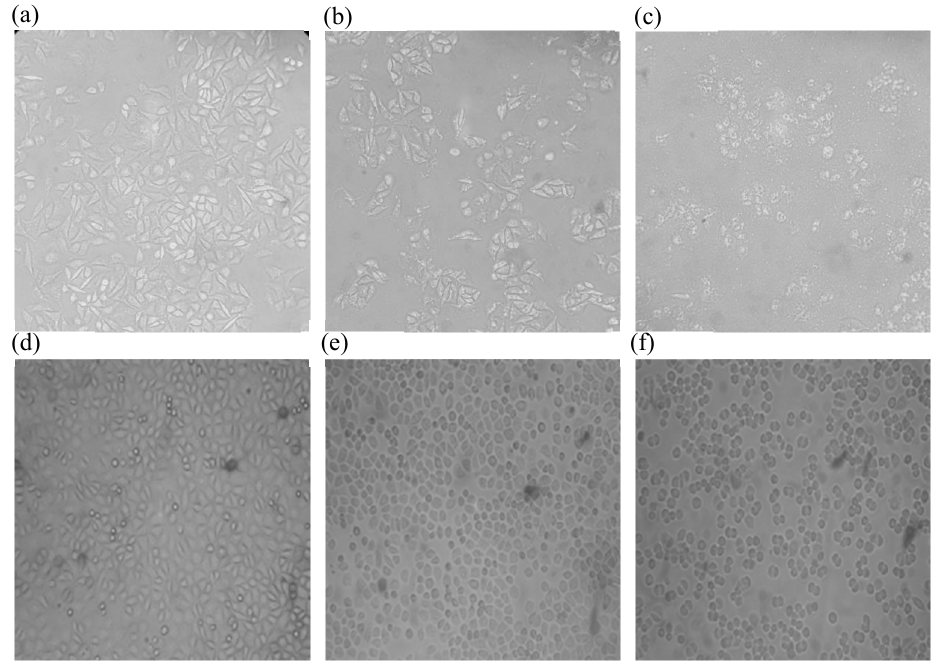
Figure 5. Effect of MRPs and MRPL on the morphology of MKN ‐ 28 ( a , b and c ) and HepG ‐ 2 cells ( d , e and f ). ( a ) Morphology of control MKN ‐ 28 cells; ( b ) Morphology of MKN ‐ 28 cells treated with MRPs; ( c ) Morphology of MKN ‐ 28 cells treated with MRPL; ( d ) Morphology of control HepG ‐ 2 cells; ( e ) Morphology of HepG ‐ 2 cells treated with MRPs; ( f ) Morphology of HepG ‐ 2 cells treated with MRPL.